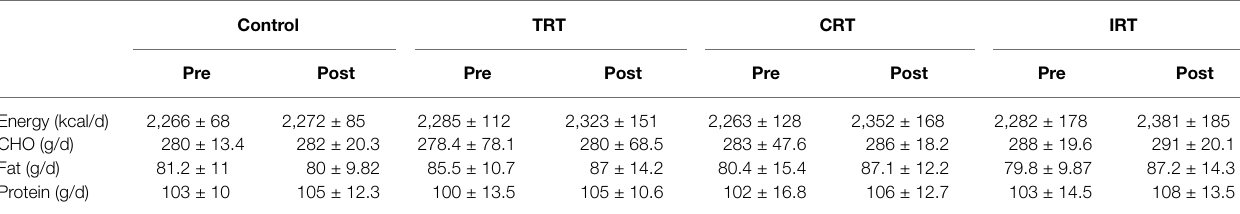
TABLE 2 | Pre- and post-values of nutritional intake in the four study